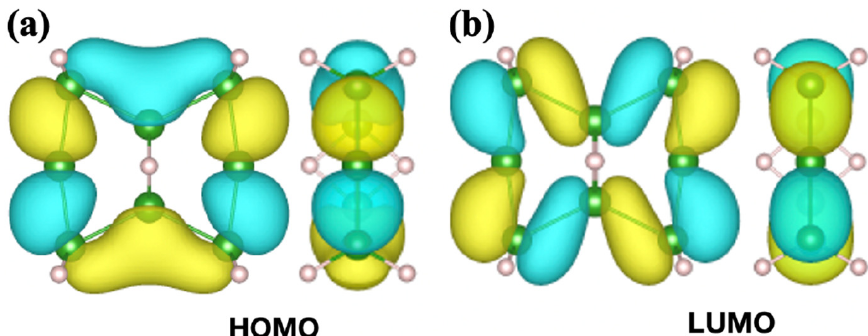
Figure 3. Top and side views of ( a ) the highest occupied molecular orbitals (HOMO) and ( b ) the lowest unoccupied molecular orbitals (LUMO) of 2:4:6:8:-2H-1,5:1,5- µ H-B 8 H 10 . The HOMO and LUMO energy levels were − 8.14 eV and − 4.05 eV with reference to the vacuum level, respectively. The colors of the molecular orbitals correspond to the sign of their wave functions.